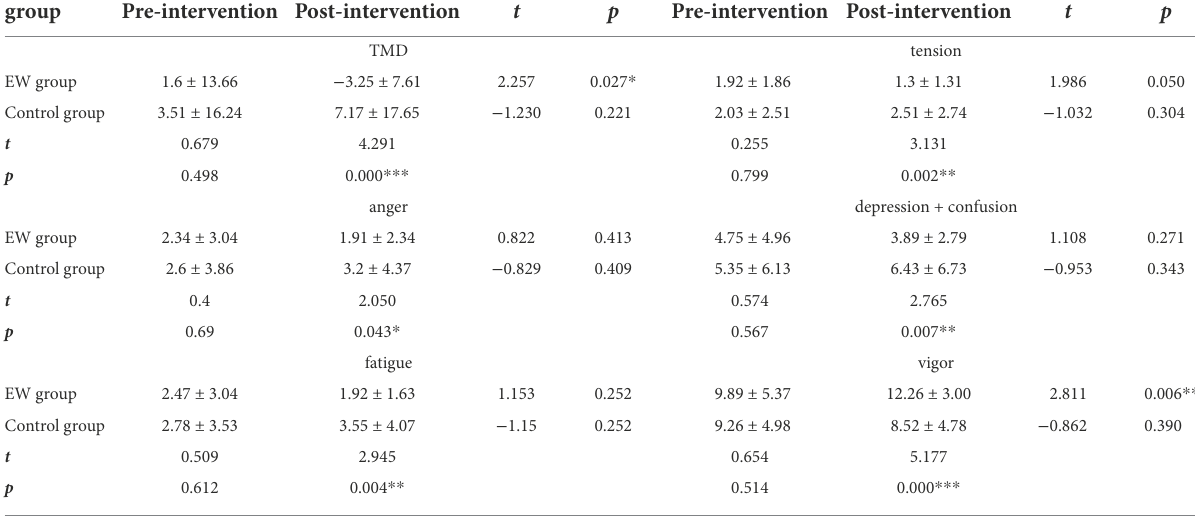
TABLE 3 Comparison of BPOMS before and after intervention between two groups (score). group